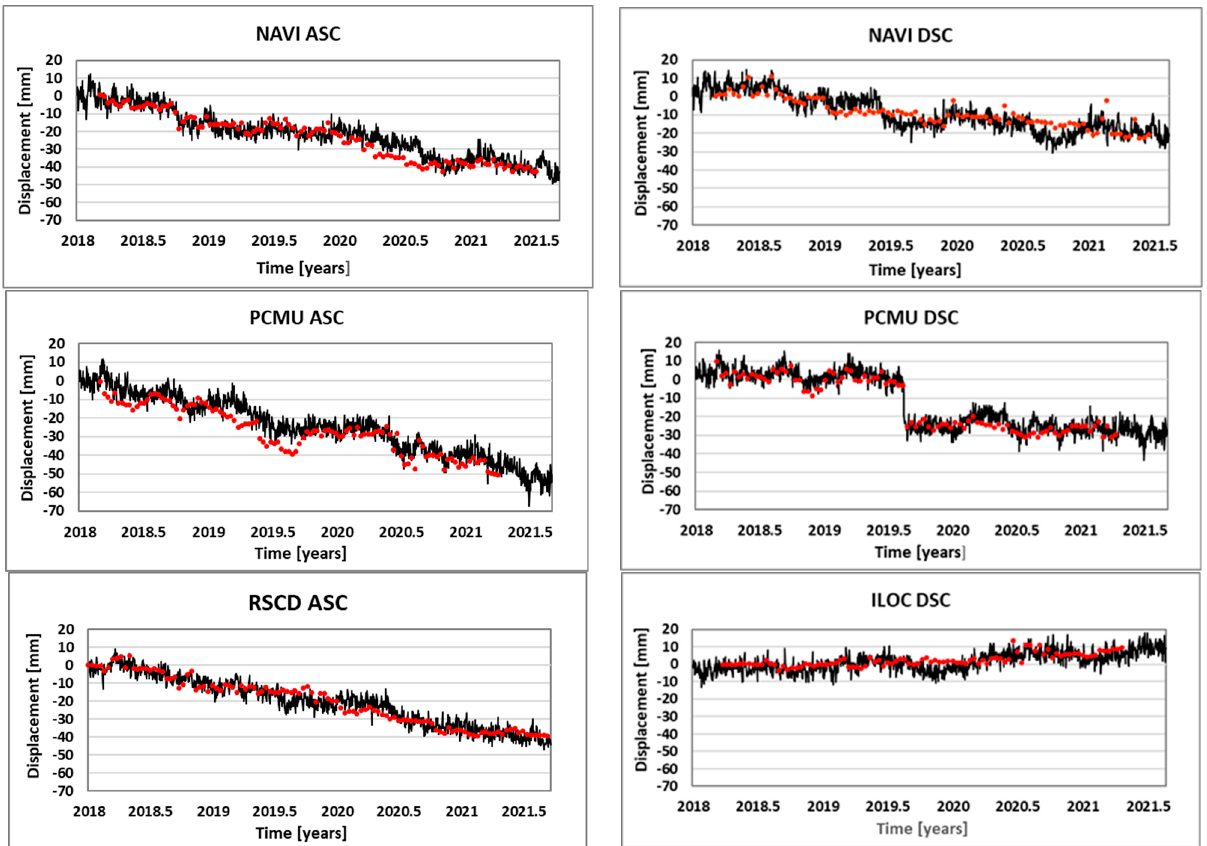
Figure 7. Comparison between the P-SBAS surface deformation time series (red points) and the projected GNSS LOS (black lines) relevant to the stations identified in the subsidence areas NAVI, PCMU, RSCD and ILOC.